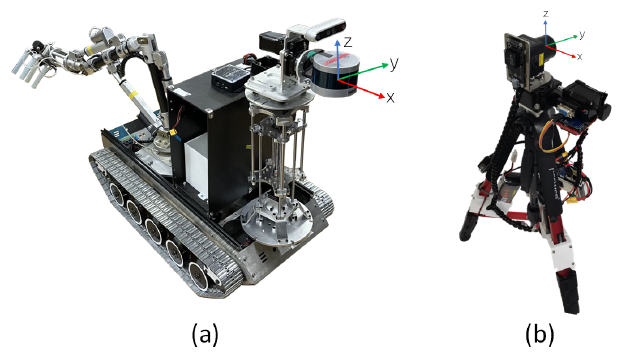
Figure 2. The equipment used in the experiment. ( a ) shows the mobile robot equipped with a 16-line rotating LiDAR. ( b ) shows the portable laser scanner used in the experiment to obtain the environmental truth value. Table 1. The parameters of the spin LiDAR equipped on the mobile robot.